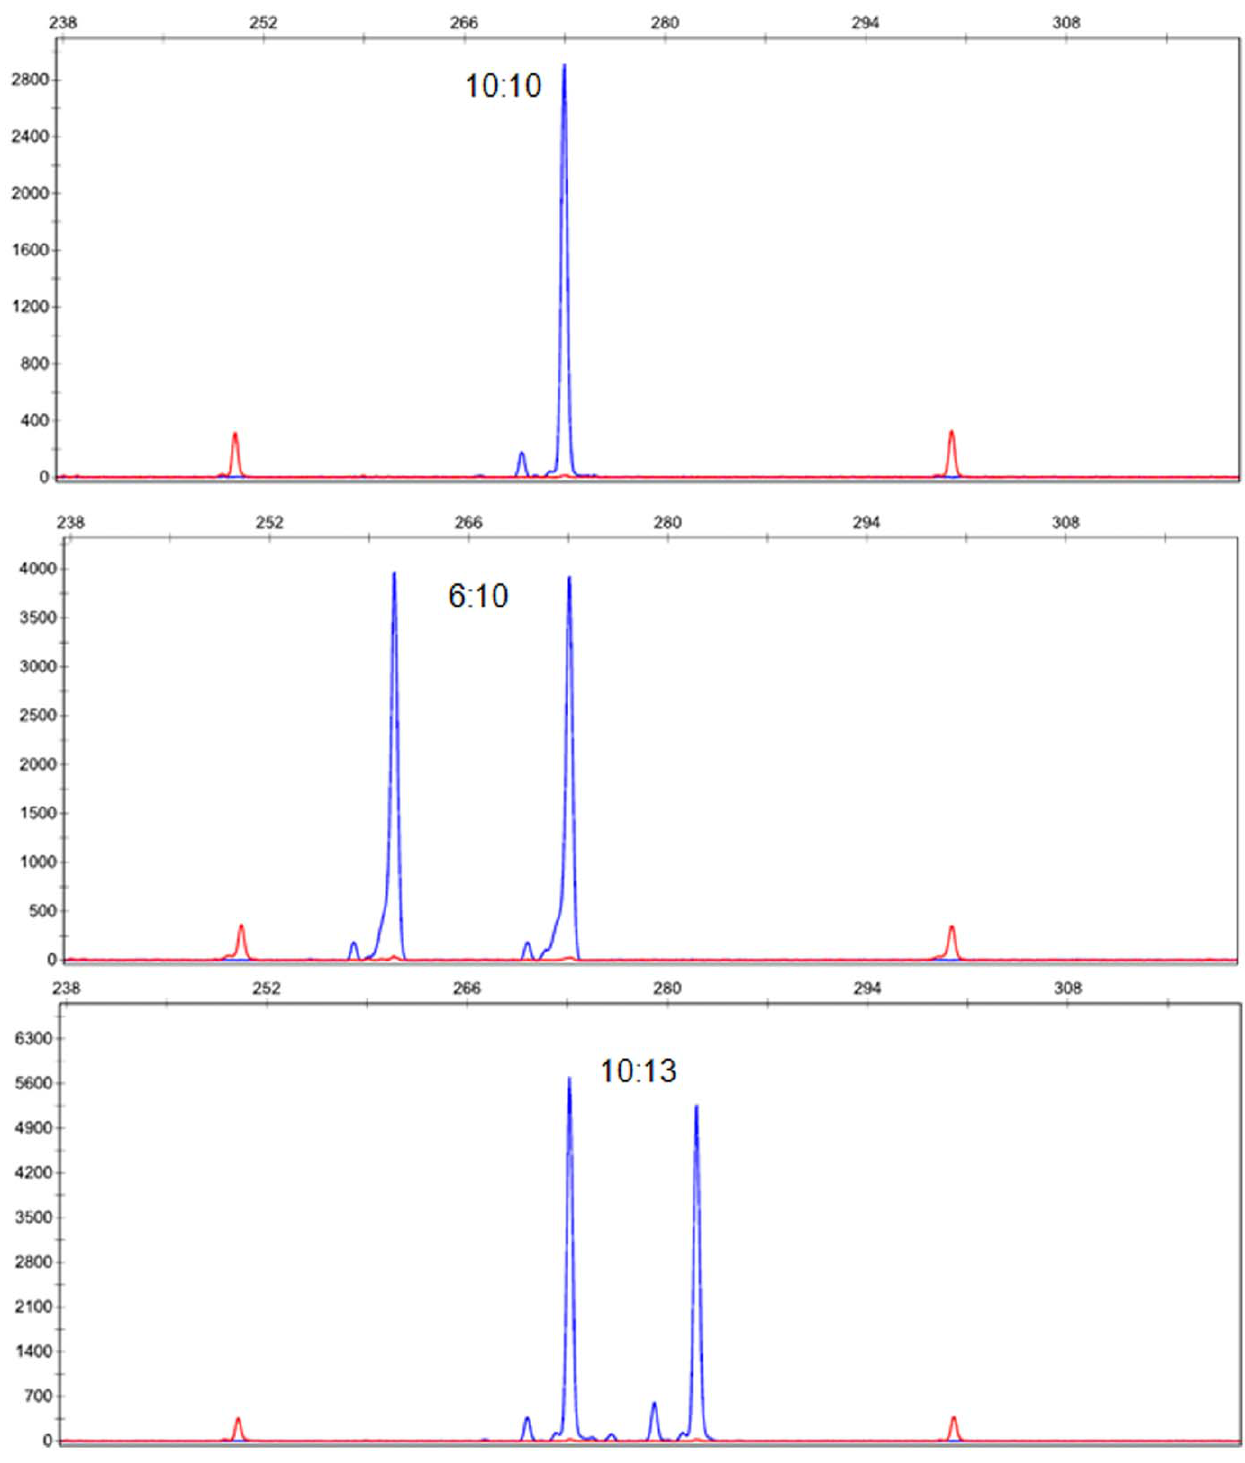
Figure 1. Representative electopherogram of normal CAG (10:10), contraction (6:10) and expansion (10:13) of POLG.